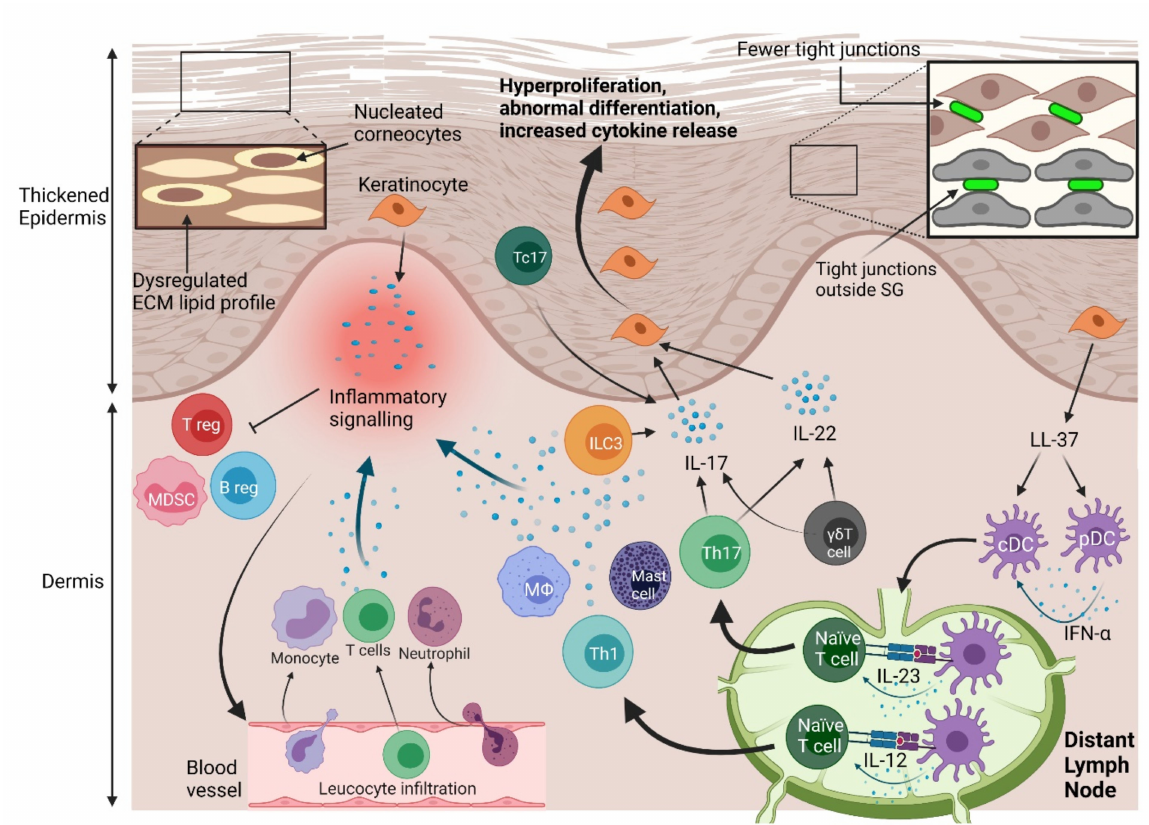
Figure 2. Physical and immune barrier disruption in psoriasis. Hyperproliferation of keratinocytes contributes to a thicker epidermis. This process is highlighted by increased expression of proliferation markers. Physical barrier function is compromised by decreased tight junction protein expression, and expression of tight junctions outside of their typical place in the stratum granulosum. Ceramide production is dysregulated in the lipidrich ECM of the stratum corneum, which also adds to physical barrier disruption. Aberrant epidermal differentiation is marked by the abnormal presence of nuclei in some corneocytes. Keratinocytes proliferate strongly in response to inflammatory cytokines, including interleukin (IL)-17 and IL-22. IL-17 is mostly produced by type 3 innate lymphoid cells (ILC3s), T helper 17 (Th17) cells, γδ T cells and the cytotoxic T cell (Tc) subtype Tc17 cells. IL-22 is produced largely by Th17 and γδ T cells. Th17 cells differentiate in response to IL-23 signals from dendritic cells (DCs), which can also compel the differentiation of Th1 cells by releasing IL-12. Plasmacytoid (p)DCs and conventional (c)DCs are activated by cathelicidin (LL-37) produced by keratinocytes. Cytokines released by keratinocytes, the aforementioned immune cells, neutrophils, macrophages (M ϕ ), and mast cells create an inflammatory environment that compels infiltration of T cells, neutrophils, and monocytes from blood vessels. Inflammatory mediators also inhibit regulatory T (Treg), regulatory B (Breg) cells, and myeloid derived suppressor cells (MDSCs). These dysregulated physical and immune responses lead to disrupted skin barrier function and, finally,